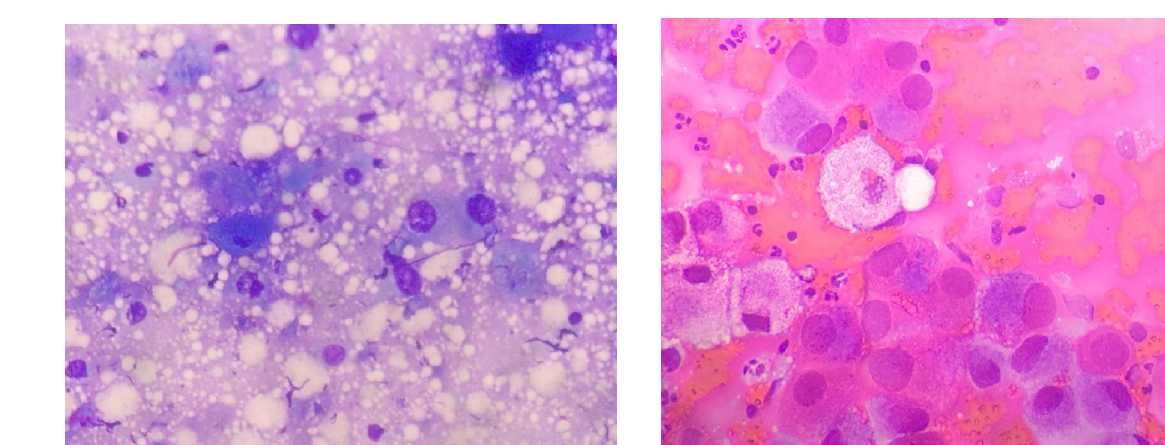
Fig 5: Pap stain showing malignant clusters of metastatic adenocarcinoma.